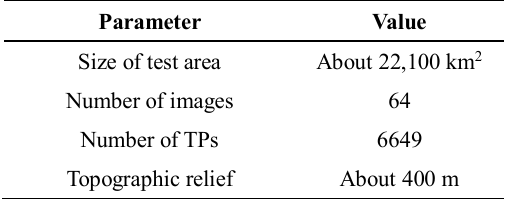
Table 1. Basic information of the experimental area.